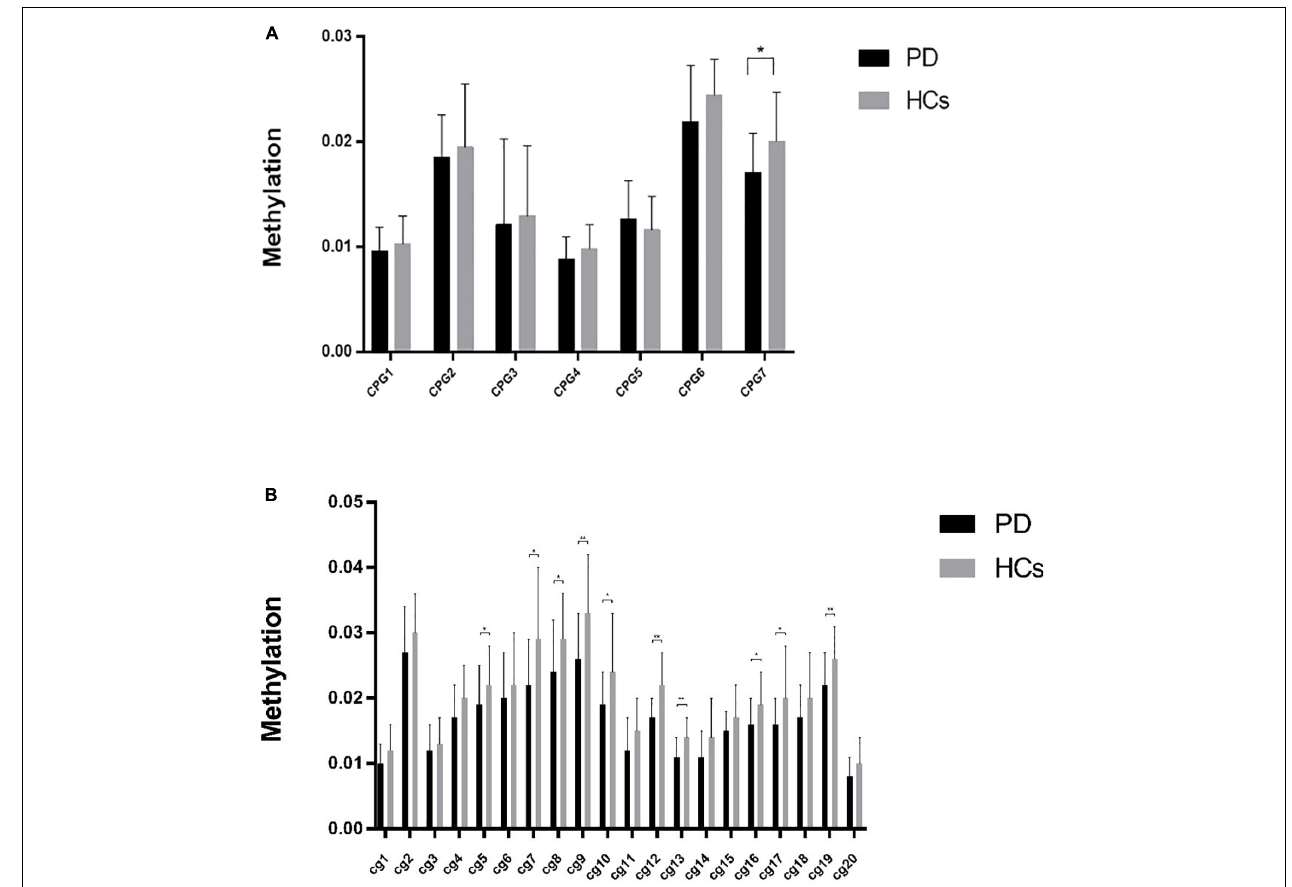
FIGURE 1 | (A) The methylation of CPG islands in GAD1 gene in the discovery sample of patients with PD and HCs. (B) Lower methylation in PD compared with controls. “*” Significant at p < 0.05; “**” significant at p < 0.01.